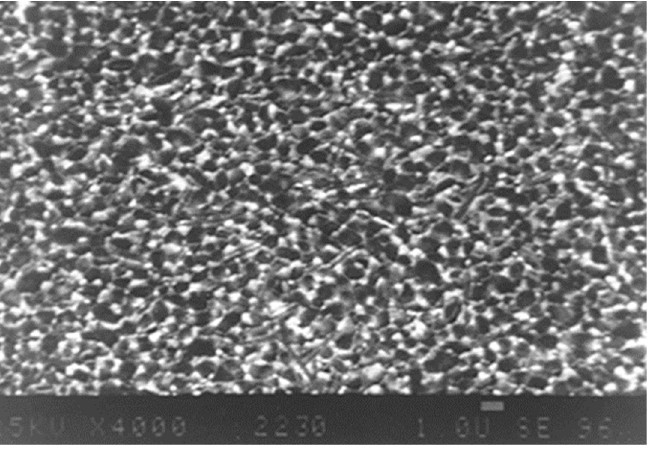
Figure 30. Microstructure of the original “Biolox delta”, containing zirconia from carbo-chlorine processing route.